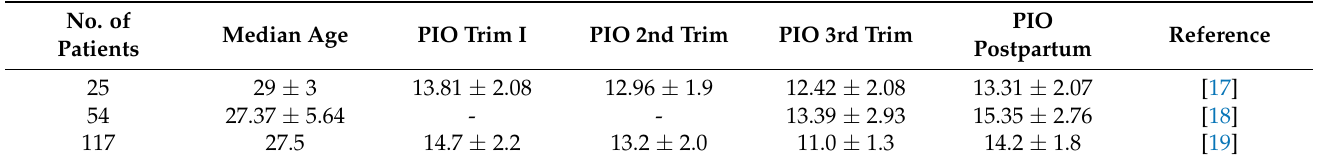
Table 1. Variation of intraocular pressure during the three trimesters of pregnancy and postpartum.